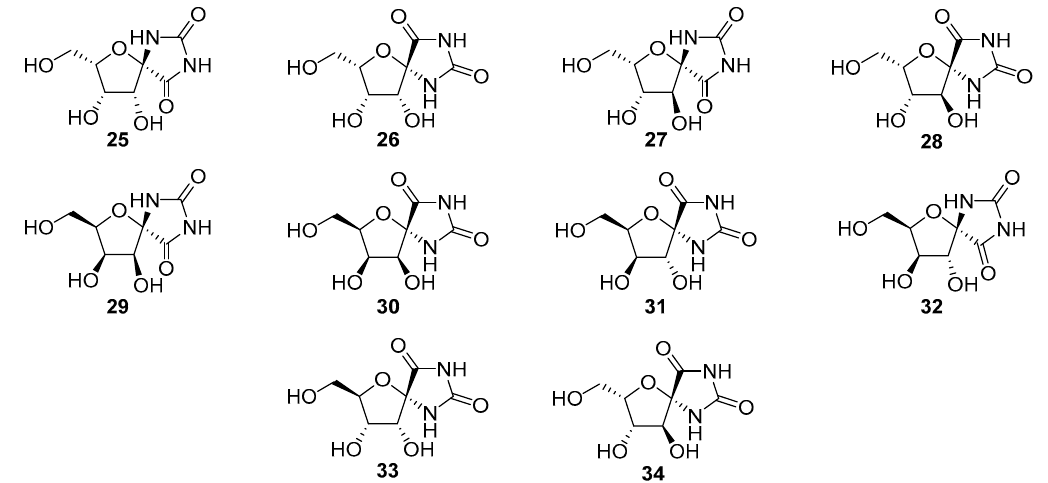
Figure 2. Examples of stereoisomers of hydantocidin.